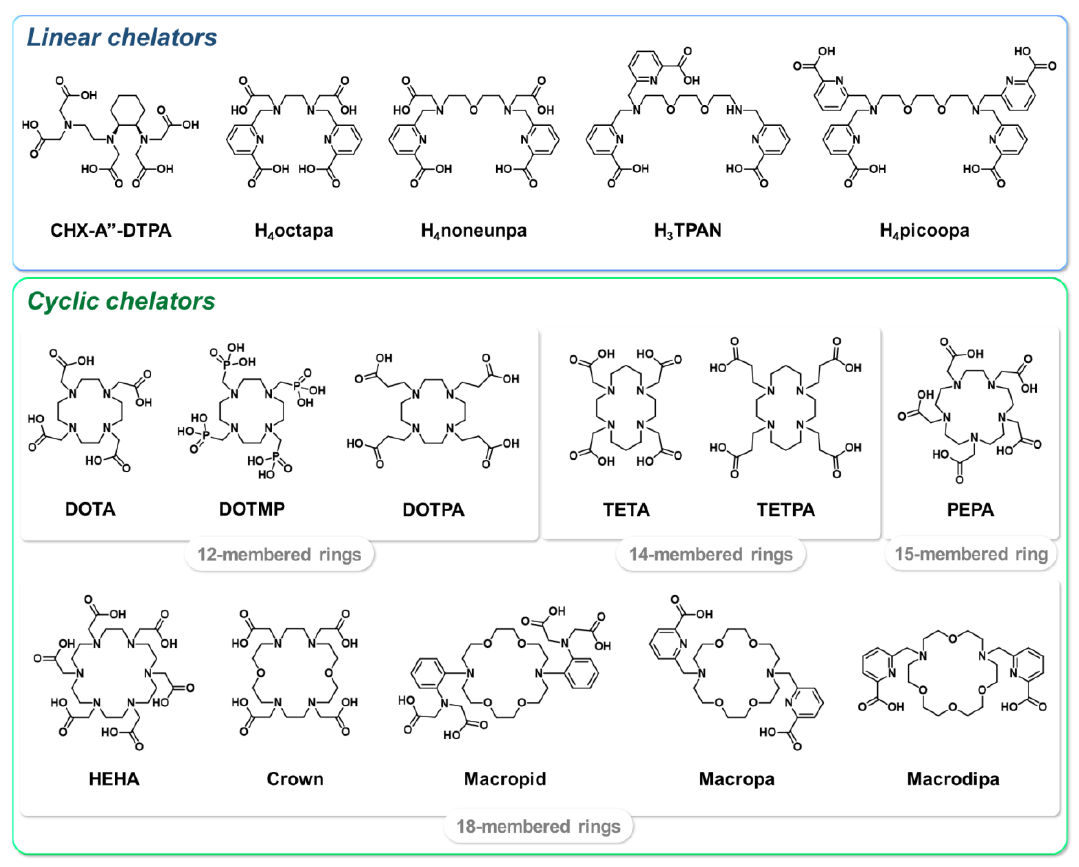
Figure 6. Selected chelators investigated for 225 Ac complexation. Despite the large variety of chelators designed and studied to easily form stable com- plexes with actinium, the 12-membered macrocycle DOTA remains one of the reference chelating agents for this radioelement, especially for radiopharmaceuticals with clinical applications. More precisely, four-arm DOTA derivatives seem to be the most suitable for complexation with 225 Ac [162]. Moreover, this chelator is already widely used in humans within theranostic radiopharmaceuticals such as DOTATOC and DOTATATE, which are already known to the regulatory authorities. Besides, the very versatile character of DOTA allows its stable coordination with various hard +3 radioactive ions such as Ga 3+ , In 3+ , Sc 3+ , Y 3+ , Lu 3+ or even Tb 3+ [163,164]. 64 Cu-labeled DOTA bioconjugates are also currently used in the clinic, but have displayed slight transchelation effects and thus a lower in vivo sta- bility over time [165]. With 225 Ac, radiolabeling conditions to form a DOTA complex are generally conventional, requiring a buffer solution such as ammonium acetate to increase the pH from 5 to 7. Interestingly, ascorbic acid is very commonly added to the reaction medium or during formulation, in order to decrease the radiolysis effects caused by the 225 Ac decay chain [162,166–171]. Radiolabeling reactions involving small molecules or peptides can be heated from 50 °C to 95 °C [158,172–174]. Harsher conditions have also been described, including microwave irradiation [172,175]. For heat-sensitive molecules, a two-step approach was reported involving the radiolabeling of the bifunctional chelat- ing agent before bioconjugation [146]. However, this approach displayed a low radio- chemical yield due to the degradation of the anchoring isothiocyanate moiety of the bi- functional agent. Optimized protocols based on the Michael addition reaction [176] or on click chemistry approaches [177,178] have been subsequently developed; nevertheless, one-step radiolabeling protocols with milder conditions are generally preferred and most